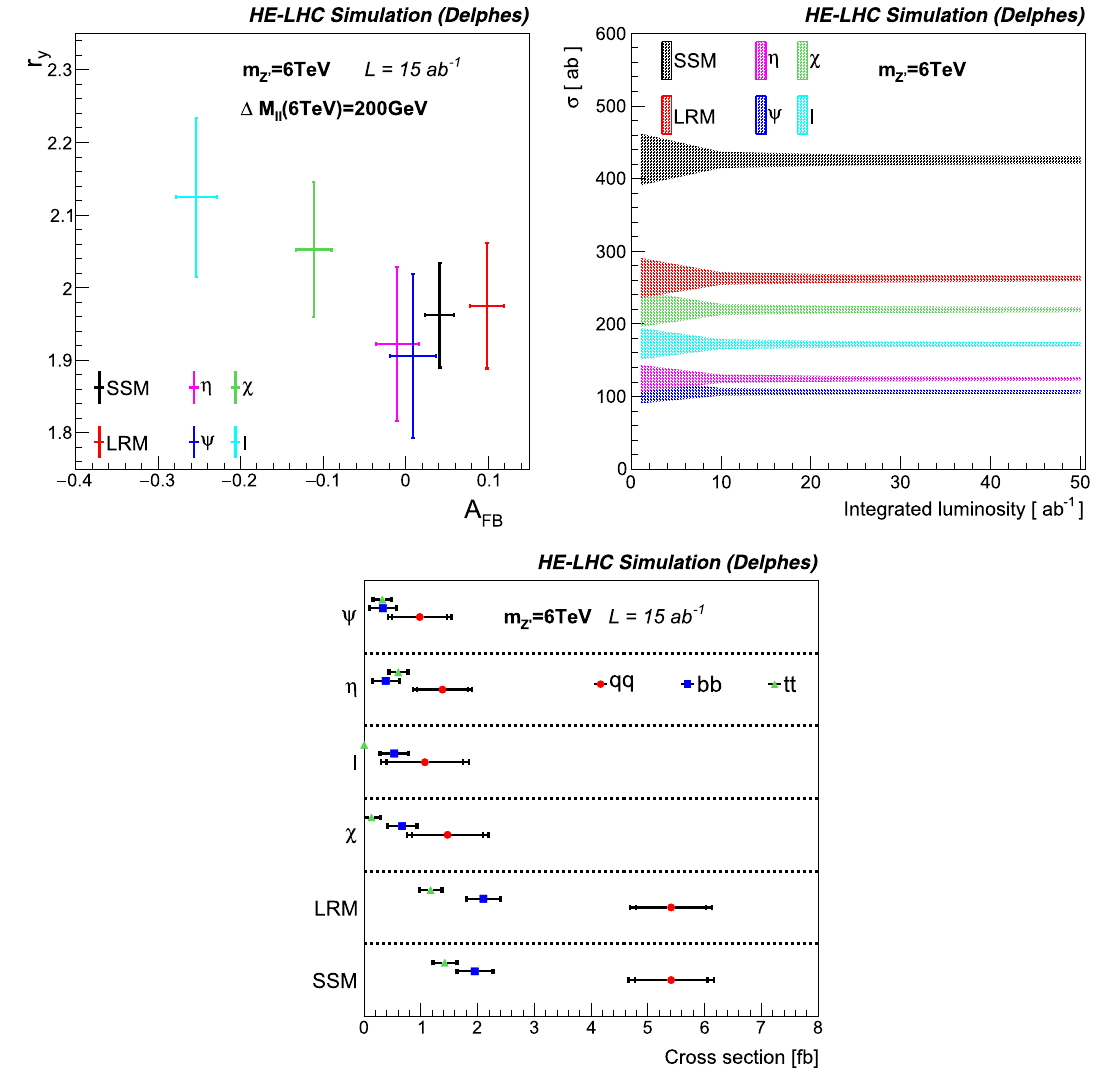
Fig. 12 Left: scatter plot of r y versus A FB with a 200 GeV mass win- dow. The full interference is included. Right: fitted signal cross-section together with its corresponding error versus integrated luminosity. Bot-